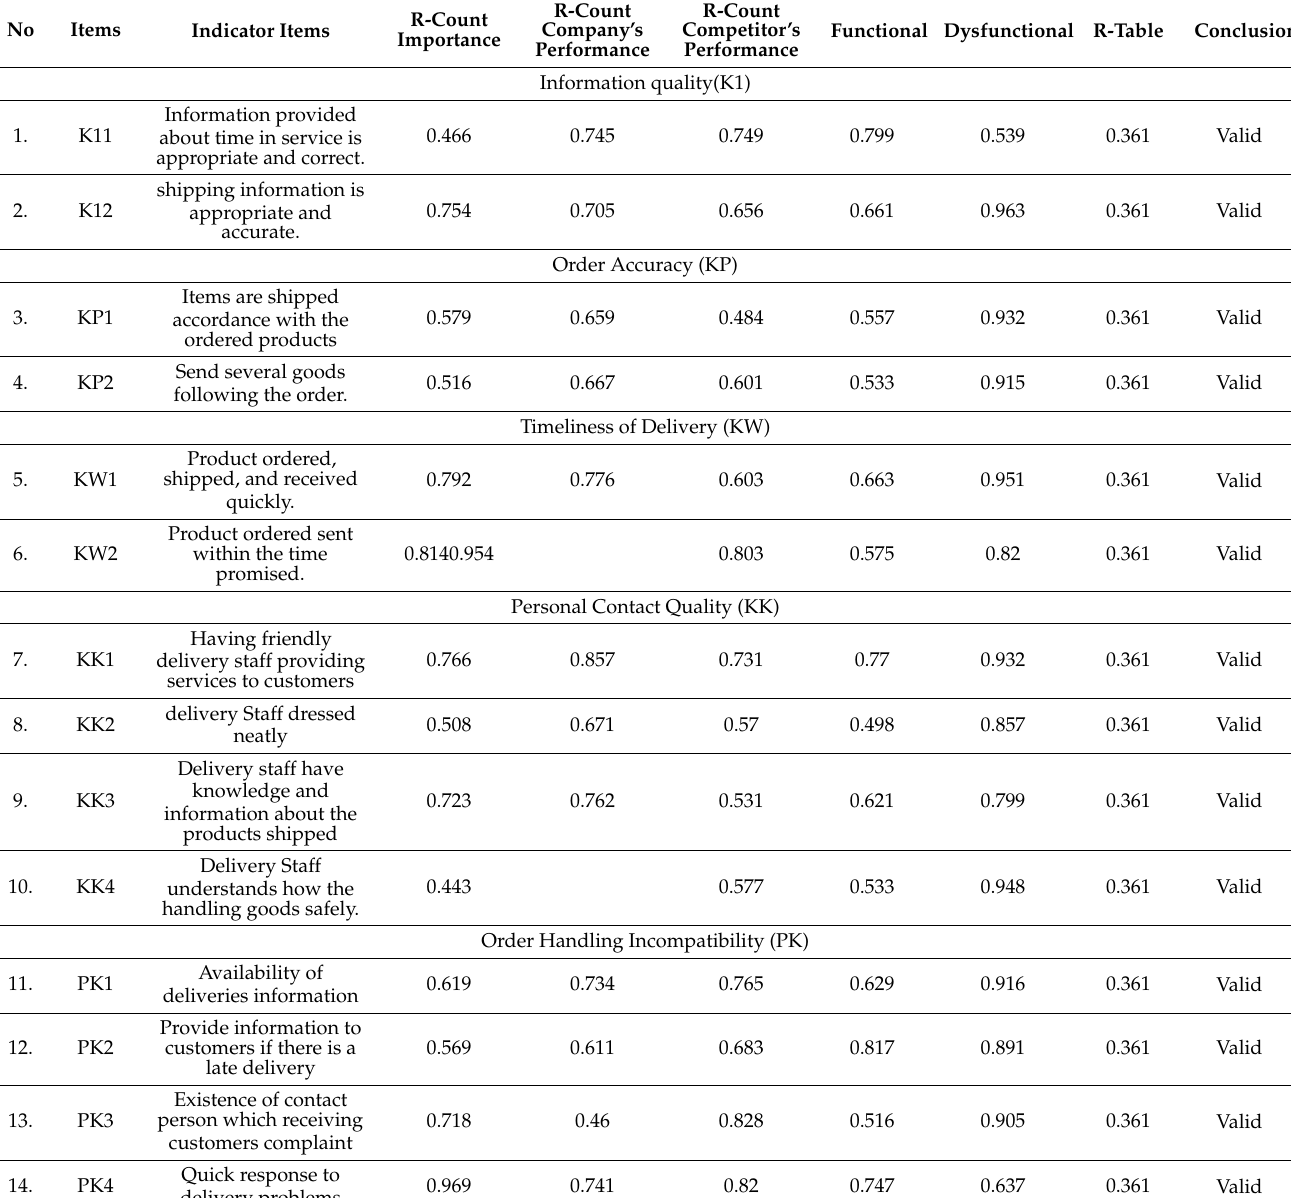
Table 4. Validity test results of preliminary questionnaire SIPA Modified-Kano. Functional Dysfunctional R-Table Conclusion